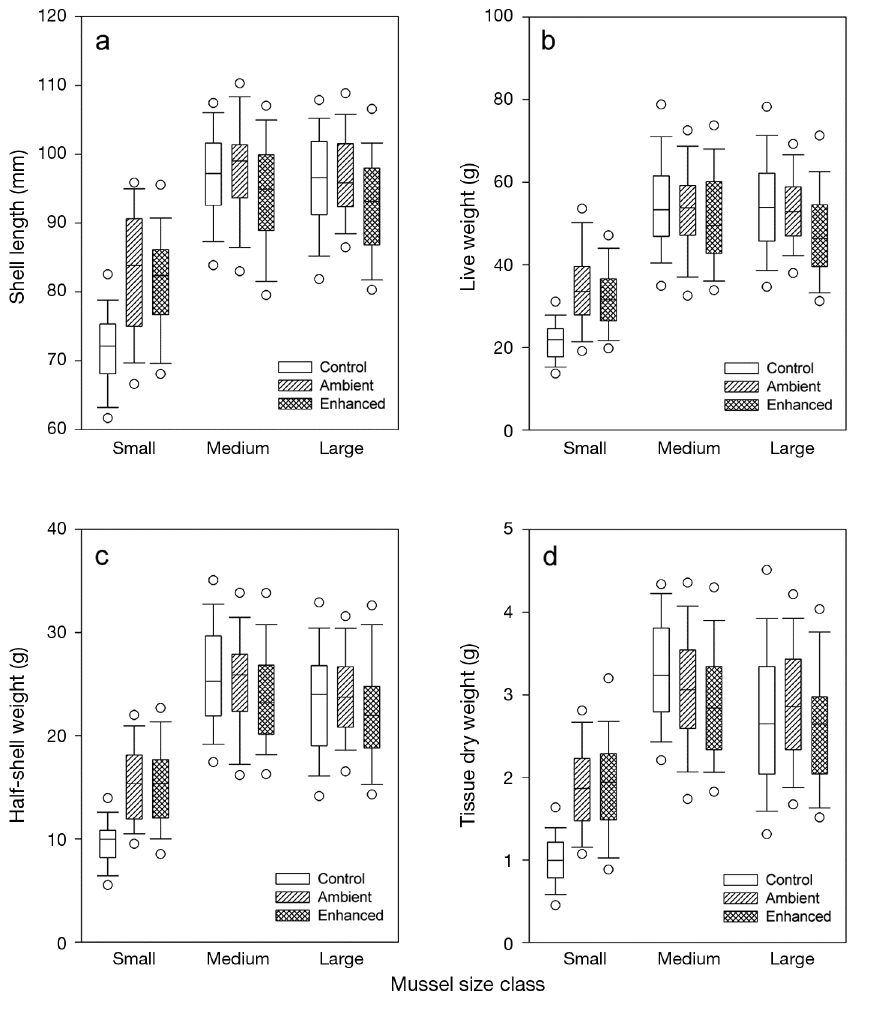
vidual mussels within the ambient fouling (82.85 ± 1.04 mm shell length and 34.41 ± 1.10 g live weight) and enhanced fouling treatments (81.53 ± 0.89 mm shell length and 31.97 ± 0.93 g live weight) were greater than in the controls (71.95 ± 0.66 mm shell length and 21.79 ± 0.64 g live weight). Table 3. Perna canaliculus . Permutational ANOVAs testing for mussel size class and fouling treatment effects on shell length and live weight (see Fig. 6a,b). Analyses based on Euclidean distances of the untransformed data, and each term was tested using 999 random permutations of appropriate units. Significant values (p < 0.05) indicated in